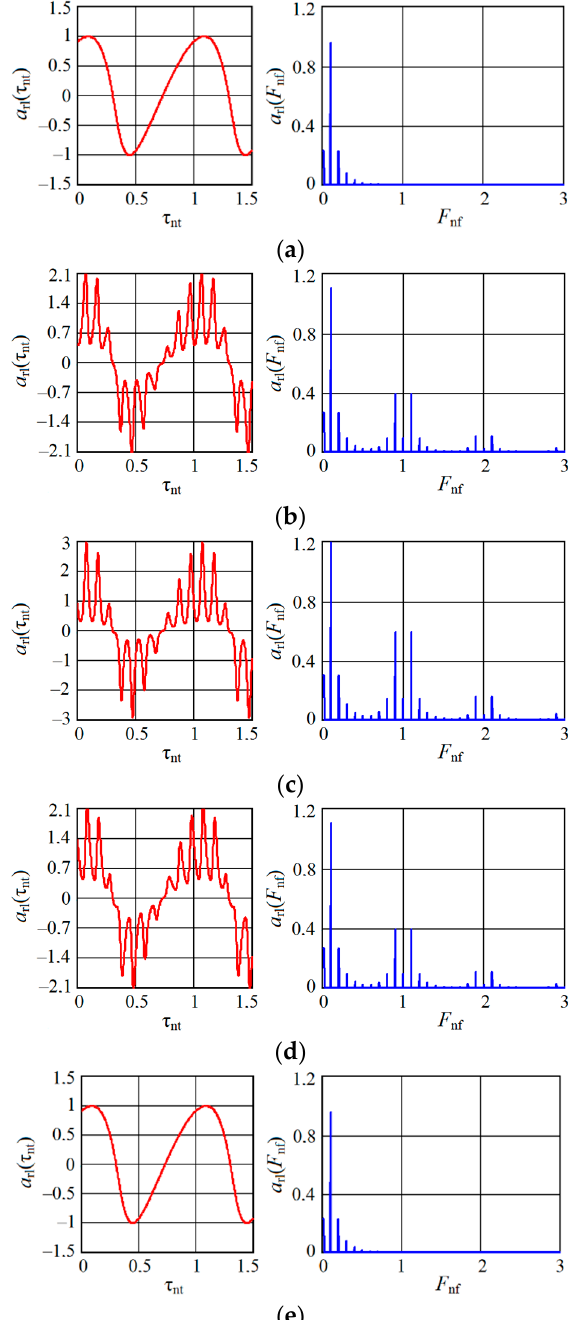
( ) a and spectral ( ) a F diagrams of the autodyne signal calculated for the Figure 7. Time τ Figure 7. Time a rl ( τ nt ) and spectral a rl ( F nf ) diagrams of the autodyne signal calculated for the oscillator rl nt rl nf with AM in absence of FM ( k FM = 0 ) and di ff erent values r nd : ( a ) r nd = 0; ( b ) r nd = 0.25; ( c ) r nd = 0.5; 0 k ) and different values r : ( a ) oscillator with АМ in absence of FM ( = FM nd ( d ) r nd = 0.75; ( e ) r nd =